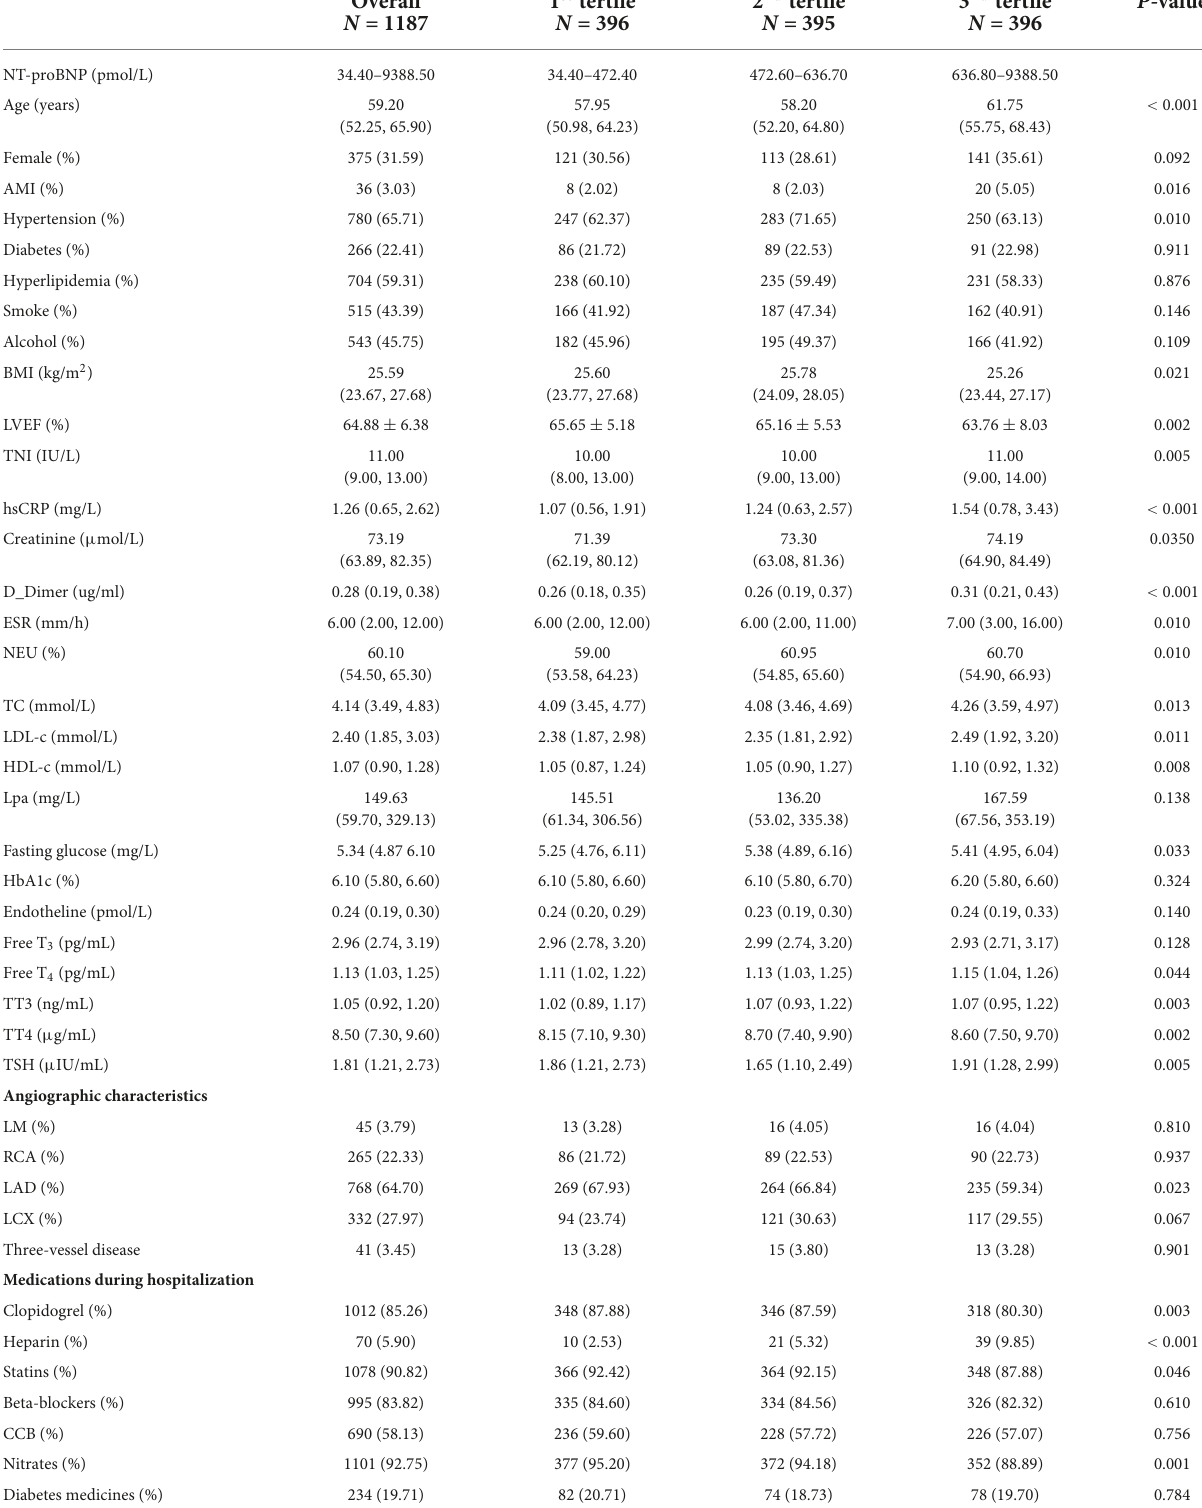
TABLE 1 Baseline characteristics between patients according to N-terminal pro-brain natriuretic peptide (NT-proBNP) tertile.